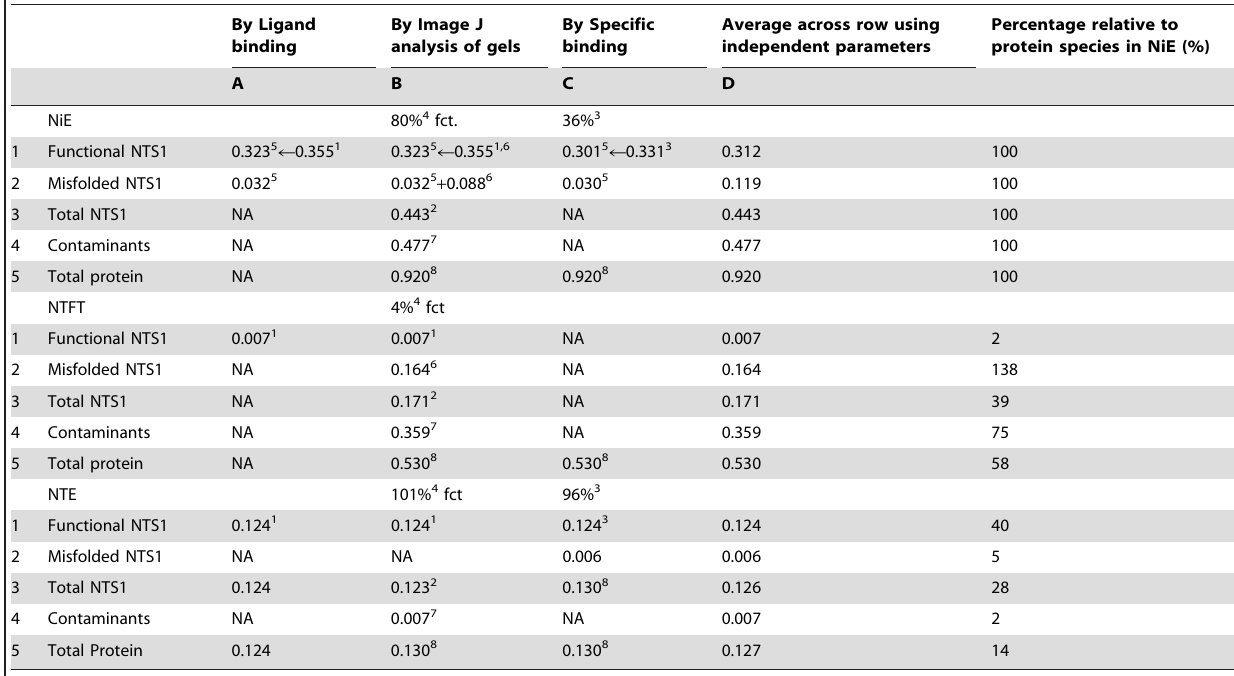
By Specific binding